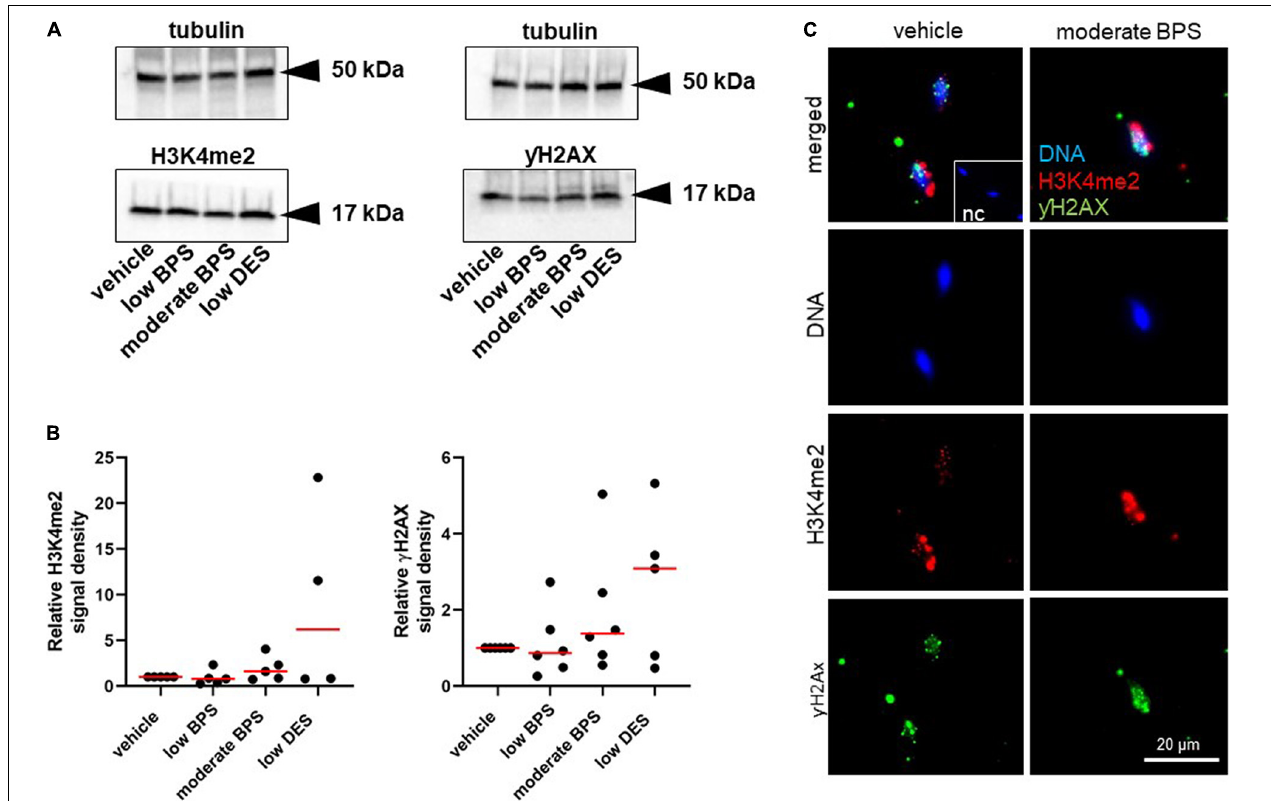
FIGURE 3 | Epigenetic quality of spermatozoa of adult males exposed to bisphenol during the nursing period. (A) Representative Western blots of dimethylation of lysine (K4) on histone H3 (H3K4me2) and phosphorylation of histone H2 ( γ H2AX) of sperm-head lysates from control, low bisphenol S (BPS-), moderate BPS-, and low diethylstilbestrol (DES-) exposed males. (B) Densitometry analysis of H3K4me2 and γ H2AX. Band signals were normalized to tubulin. Dots represent individual males, and red lines show the median. (C) Immunocytochemistry assay of H3K4me2 and γ H2AX expression in mouse spermatozoa of vehicle control and moderate BPS; the NC was prepared by omitting a specific antibody and incubated with fluorescein-conjugated antibody. NC: negative control; BPS: bisphenol S; DES: